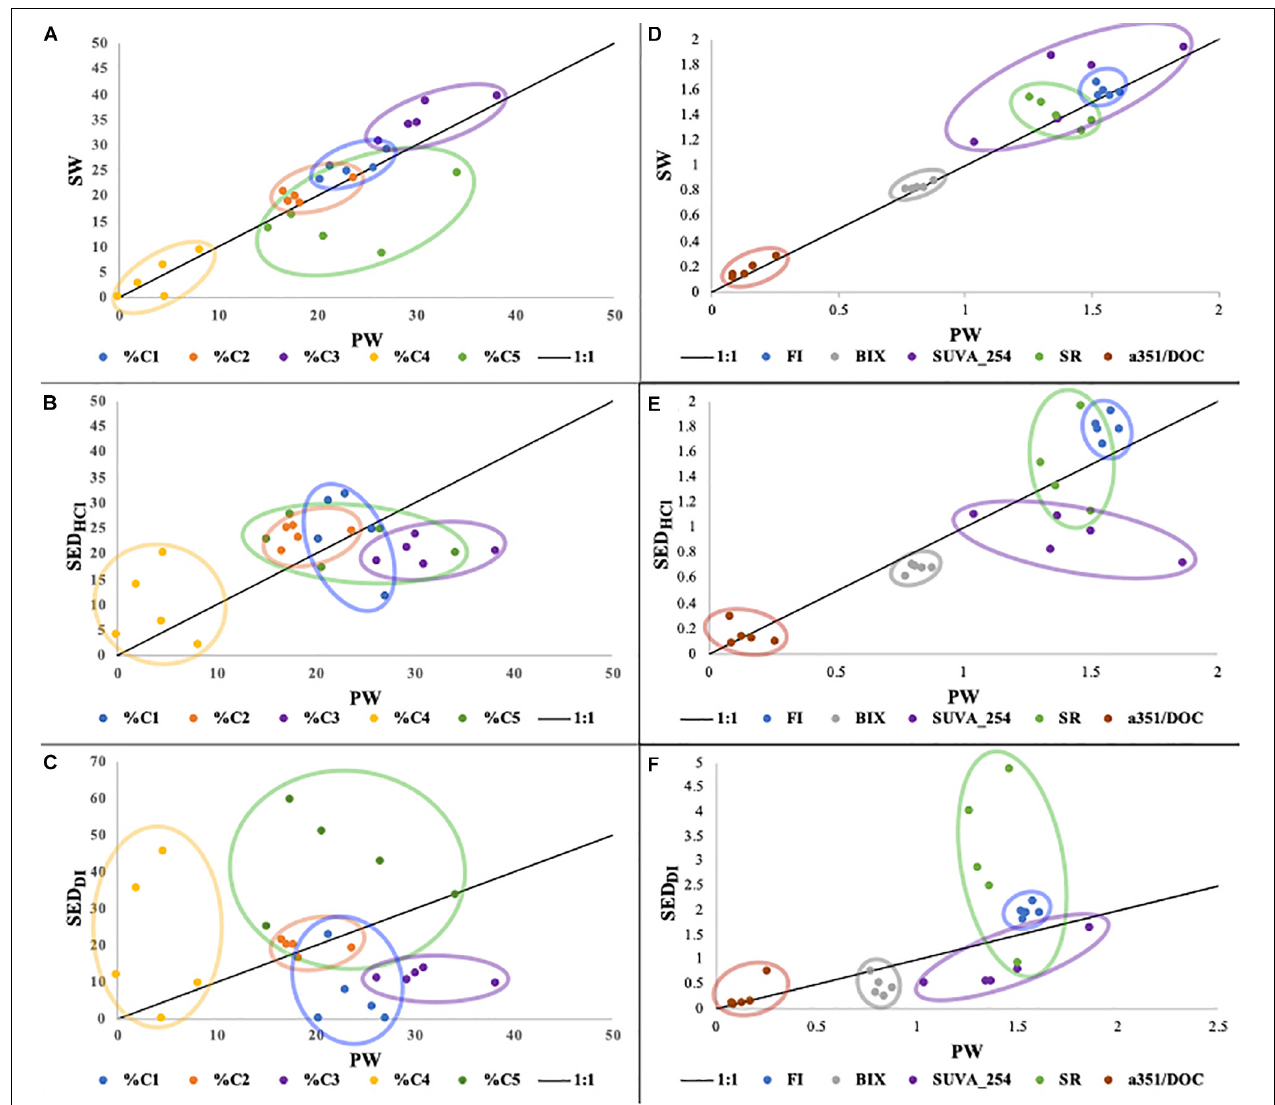
FIGURE 4 | Comparison of PARAFAC component composition (A–C) and other optical properties (D–F) for the 5 Florida Bay sites (DK, SB, LM, BA, and TC) and 4 pools (SW, PW, SED HCl , and SED DI ). PW is on the x -axis, with either SW (A,D) , SED HCl (B,E) , or SED DI (C,F) on the y -axis. One sample was used for each site and each pool ( n =